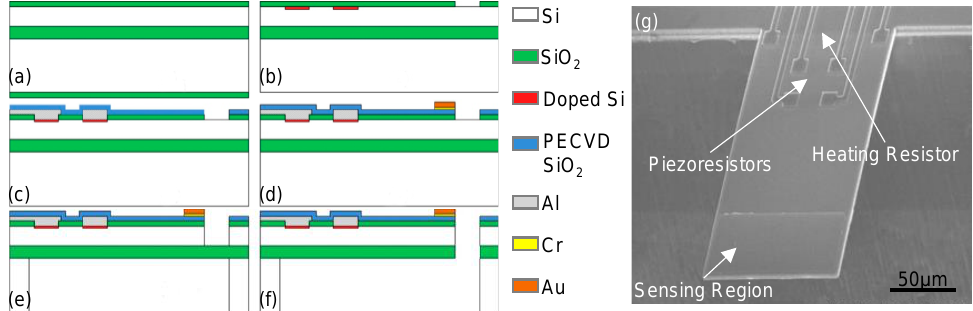
Figure 2. Bending-mode cantilever mass sensors. ( a – f ) Fabrication process of microcantilevers showing on-chip integration of electrothermal excitation and piezoresistive readout. ( g ) Typical resonant sensor with sensing region at the free end for nanomaterial loading. Reprinted with permission from [18]. Copyright 2009 IOP Publishing Ltd.